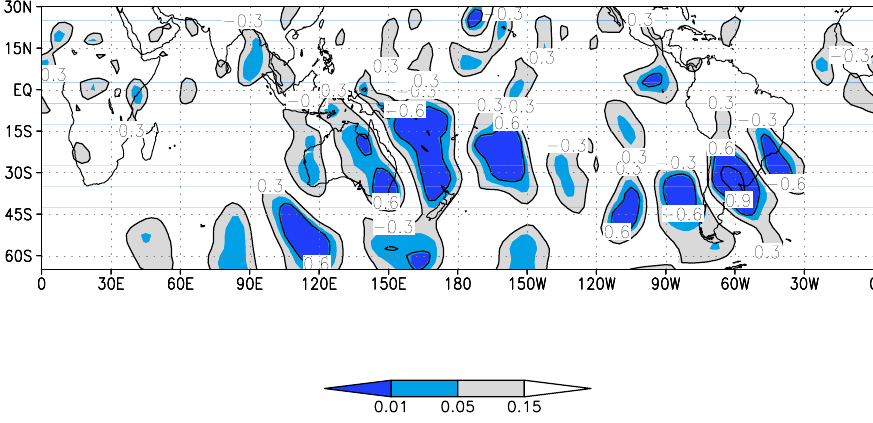
Figure 10: Fig. 10. Correlation fields between the averaged meridional wind over the Wet Pampa area during GF events and the global meridional wind at 250hPa (lag 0). Only significant values at the 95% level are shown and indicated by the shaded